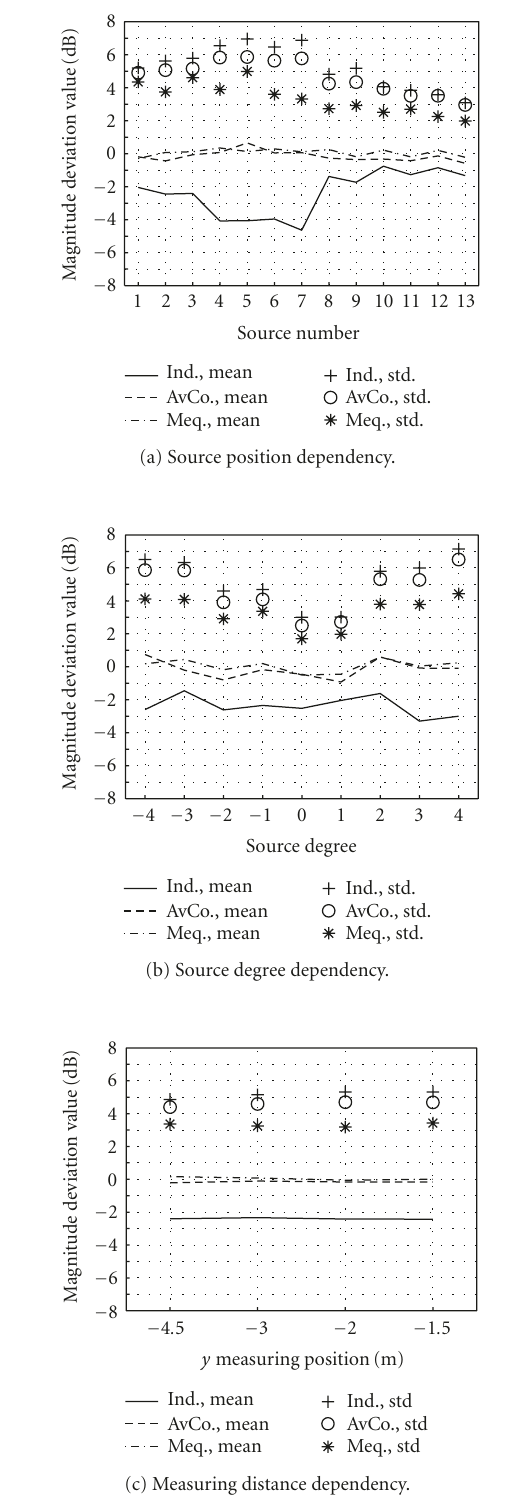
Figure 13: Mean value (mean) and standard deviation (std) of evaluated below the aliasing frequency for all microphone MAG Ψ m and source positions. Comparison between individual equalization (Ind), individual equalization + average synthesis error compensa- tion (AvCo), and multichannel equalization (Meq) for MAP loud-